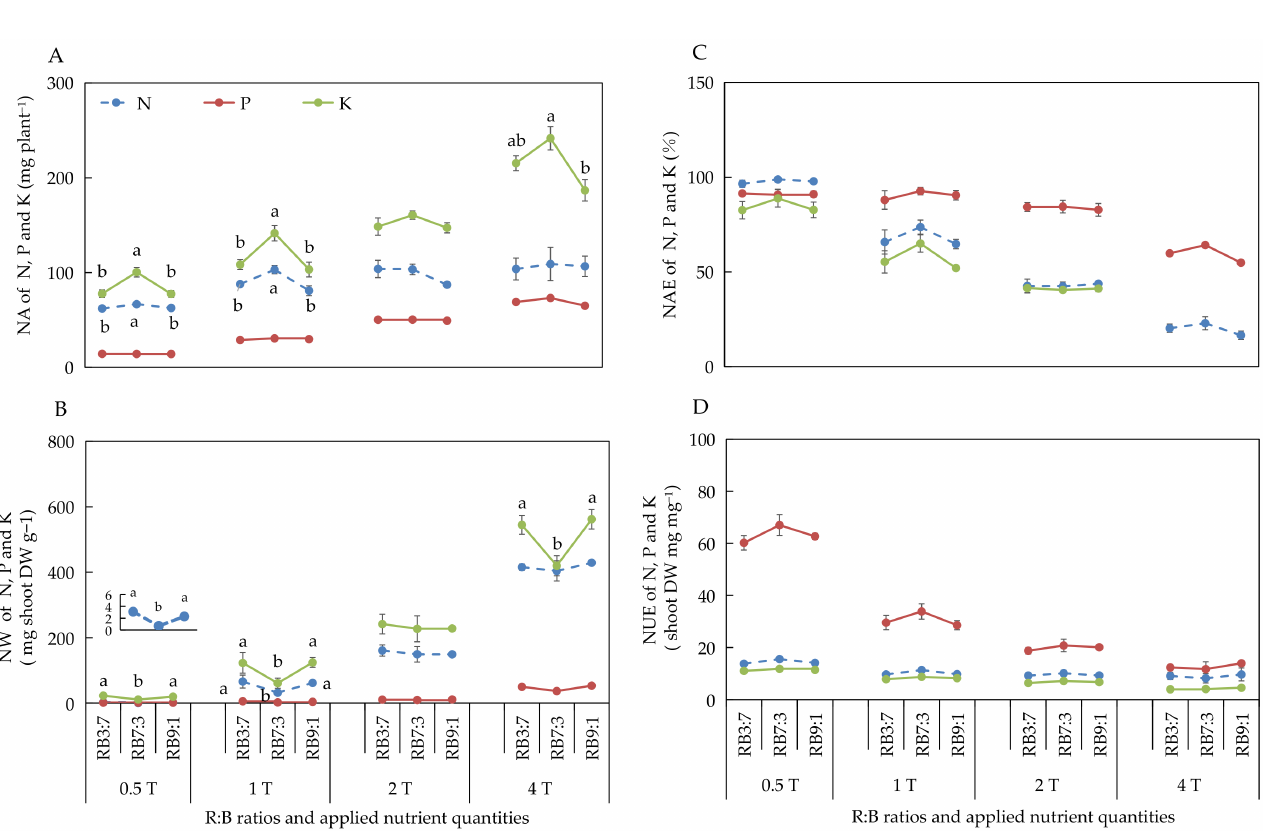
Figure 5. Nutrient absorption (NA) ( A ), nutrient waste (NW) ( B ) from producing 1 g shoot dry weight, nutrient absorb efficiency (NAE) ( C ), and nutrient use efficiency (NUE) ( D ) of shoot dry weight of N, P, and K after 20 days of cultivation under different ANQ treatments and R:B ratios. 0.5T, 1T, 2T, and 4T represent 4 different ANQ treatments. RB3:7, RB7:3, and RB9:1 represent the R:B ratios of 7:3, 3:7, and 9:1, respectively. The small graph in Figure 5B represents the NW of N at different R:B ratios under 0.5T. The error bars represent SEs (n = 3). On the basis of Tukey’s new multiple range test at p < 0.05. Different lowercase letters represent significant differences among different